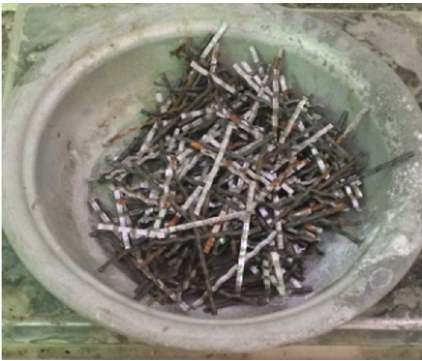
Fig. 8 Steel fibers used in this work Table 3 Mechanical properties of the